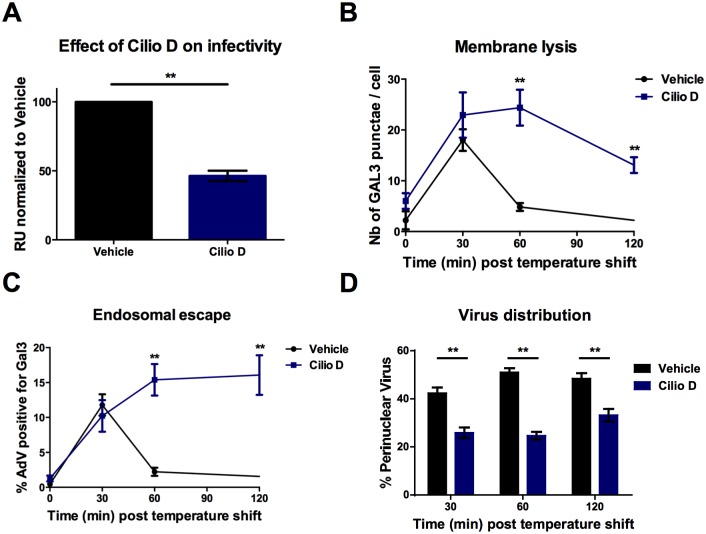
AdV endosomal escape is dynein dependent.(A) Cells were pretreated with 100 μM of Ciliobrevin D for 30 minutes or DMSO and transduced with GFP expressing WT vector in presence of drugs. Twenty four hours later transduction levels were determined by FACS and normalized for the vehicle control (B) Cells were infected with fluorescent viruses in presence and absence of 100μM CilioD and fixed at different time points. The number of Gal3 punctae per cell was determined (C) Cells were infected as in B. Colocalization between Gal3 and AdV signals was quantified and is displayed as percentage of colocalization. (D) Cells were infected as in B. Fluorescent viruses in control or drug treated or control cells were quantified at indicated time points in the perinuclear region vs. the rest of the cytosol. Error bars (SE) show cell-to-cell variations.